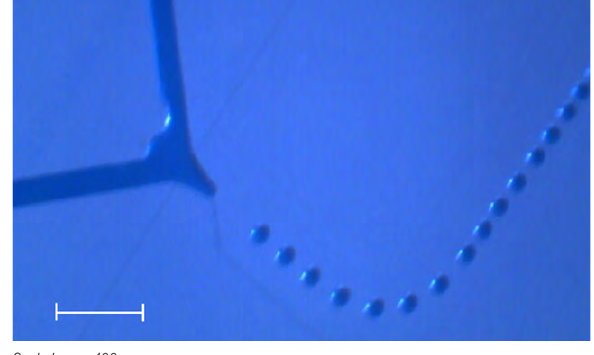
Figure 9: Water-in-oil droplet generation demonstrated on the centrifugal microfluidic platform, with the disc rotating at a speed of 550